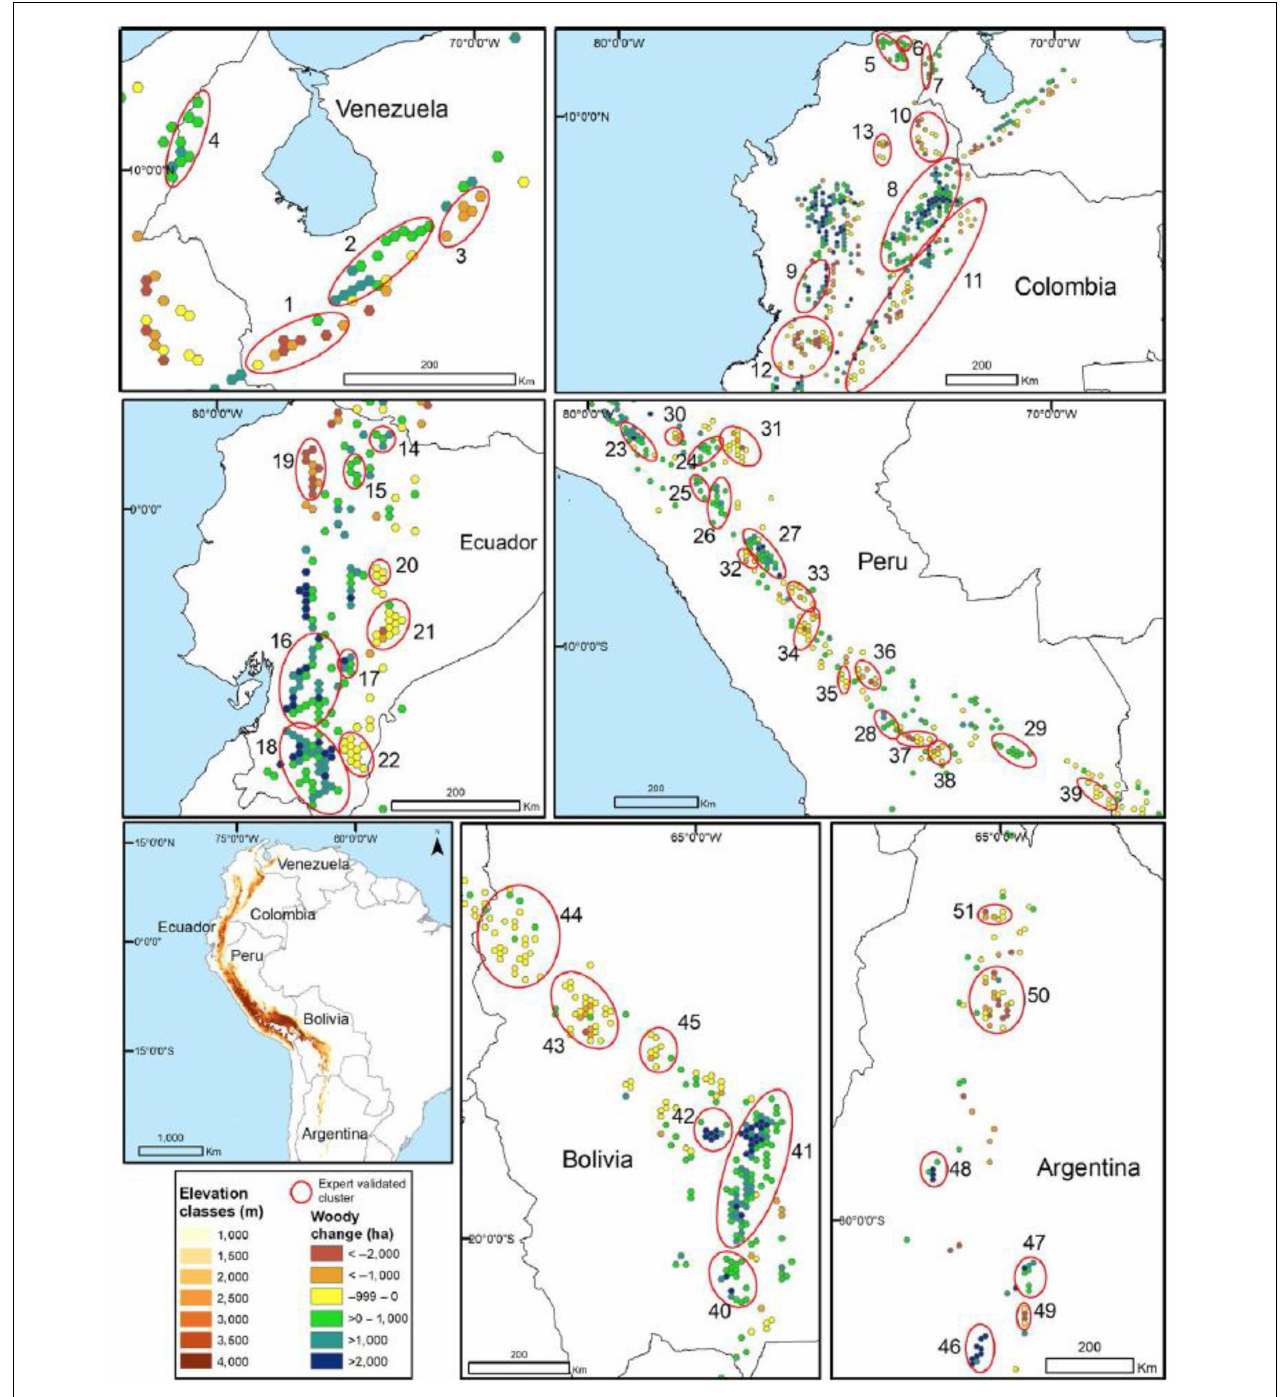
FIGURE 5 | Distribution of elevation classes within the tropical and subtropical Andes and hexagons with a significant 14-year linear increase or decrease in woody vegetation in each country. From Aide et al.